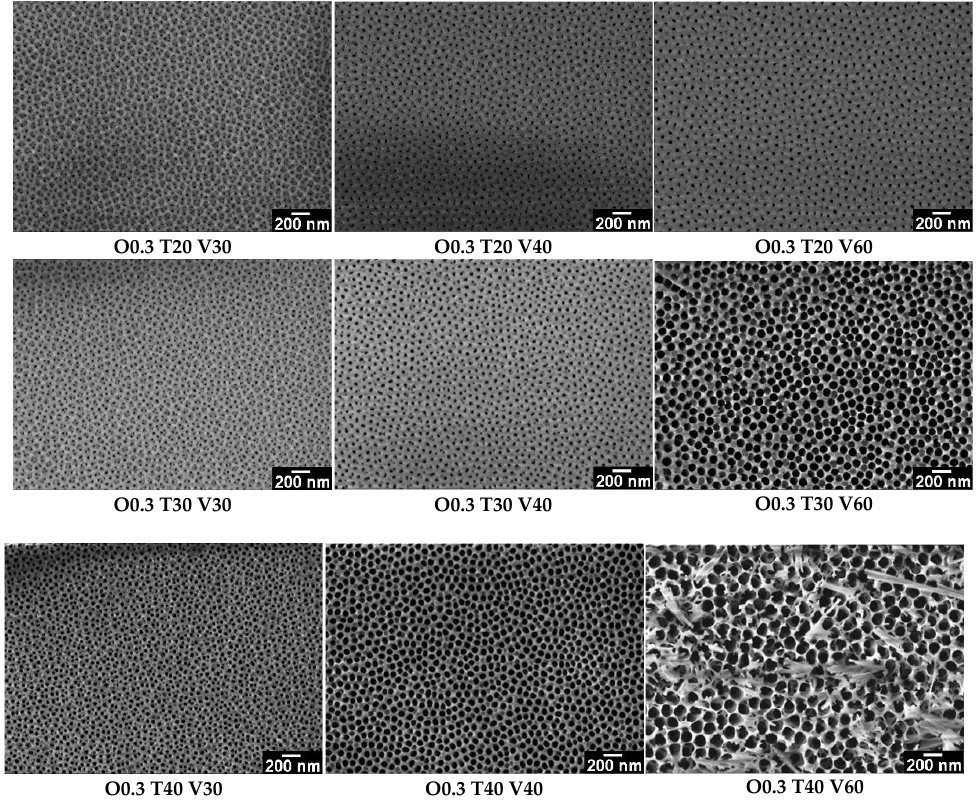
Figure 2. SEM images of nanostructured anodic aluminum oxide (AAO) films obtained by means of a one-step anodization process of 1 h in 0.3 M oxalic acid at different temperatures and voltages. Table 2. Average values of the morphological parameters of nanostructured AAO coatings obtained in 0.3 and 0.9 M oxalic acid at different temperatures and anodization voltages ( C is the oxalic acid concentration, T the electrolyte temperature, V the anodization voltage and S is the nanoporous